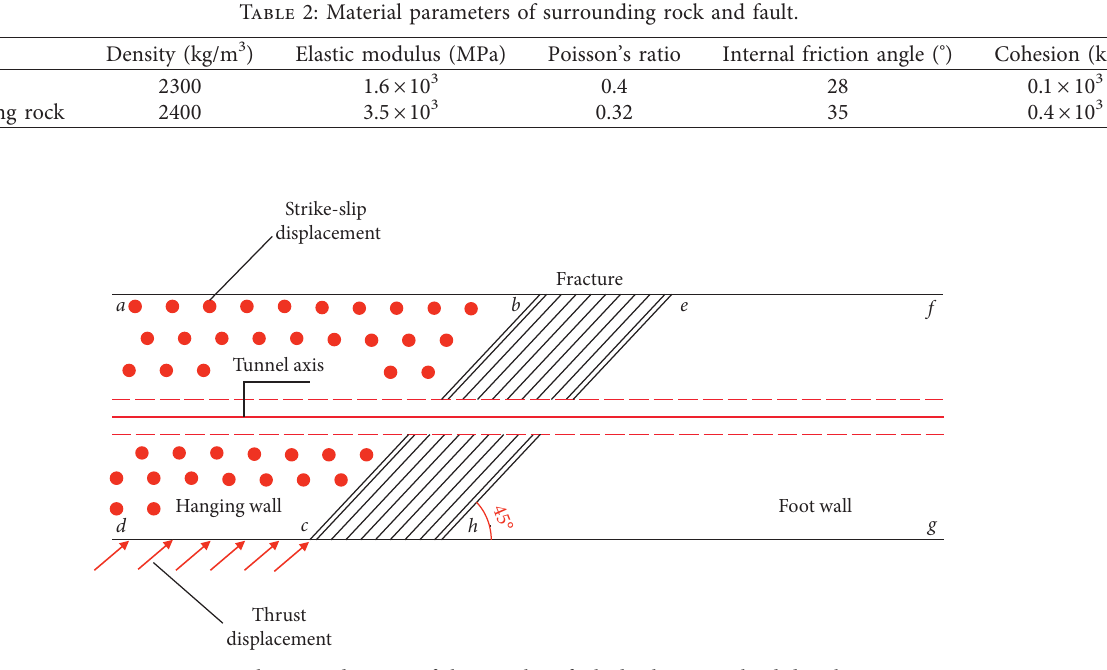
Figure 2: Schematic diagram of the coupling fault displacement load distribution.